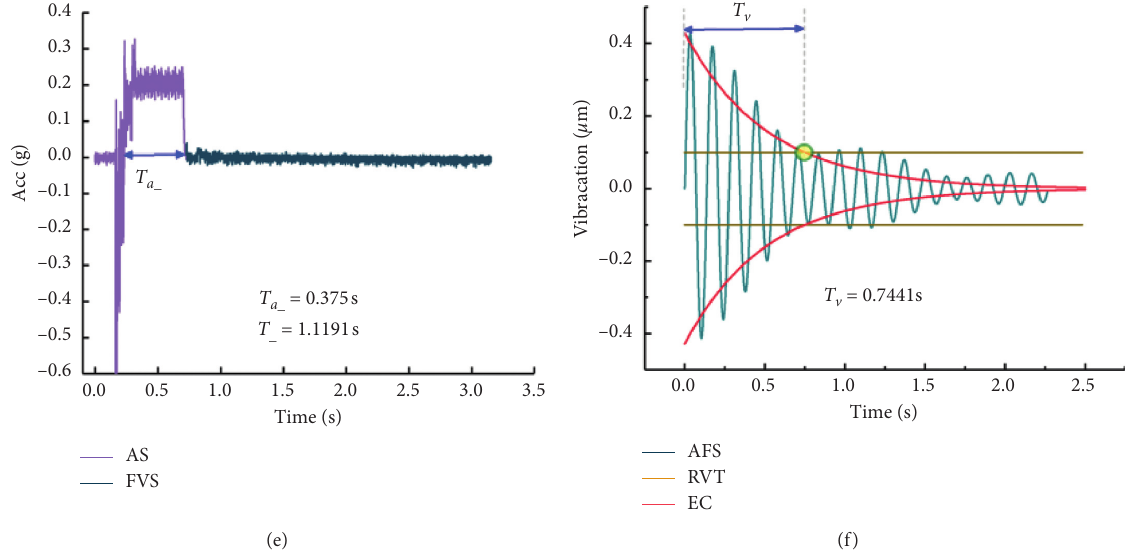
Figure 11: Residual vibration signal and corresponding delay time for different a T − � 1.1432s; (c) and (d) a − � 1.46m s − 2 , T − � 1.1019s; (e) and (f) a − � 2 m s − 2 , T − �